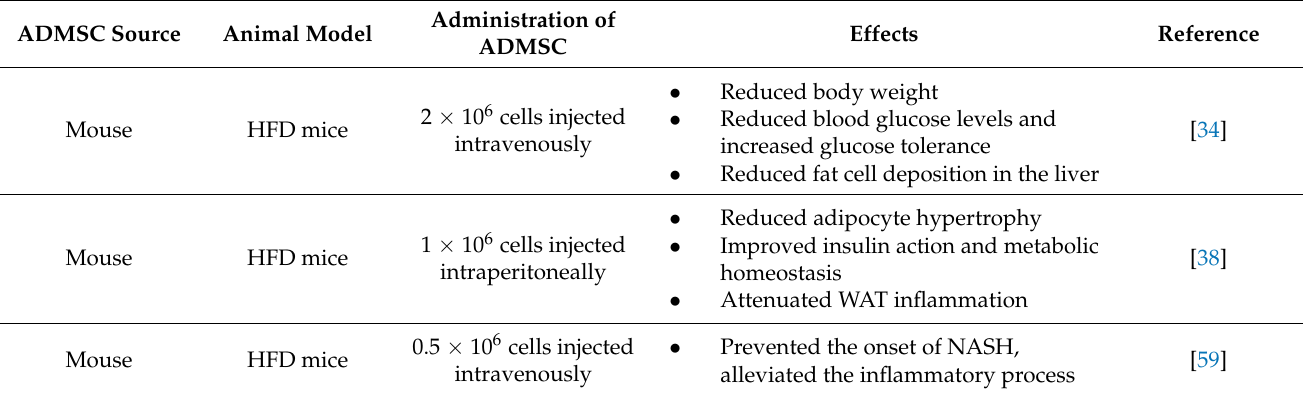
Table 1. The most relevant pre-clinical studies exploring the therapeutic efficiency of ADMSCs in the treatment of obesity and its metabolic